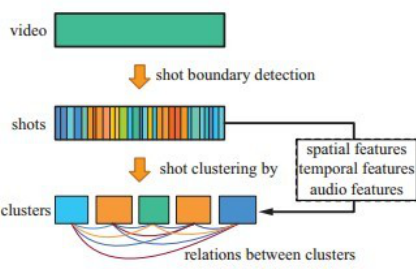
Figure 24. Chen et al. presents video shot clustering algorithm combines both visual and audio features to generate a meaningful storyline [47]. Image courtesy of Chen et al.